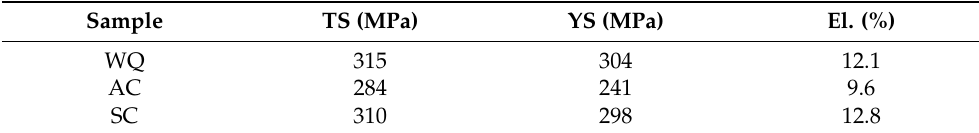
Table 2. Tensile test results (mean of five